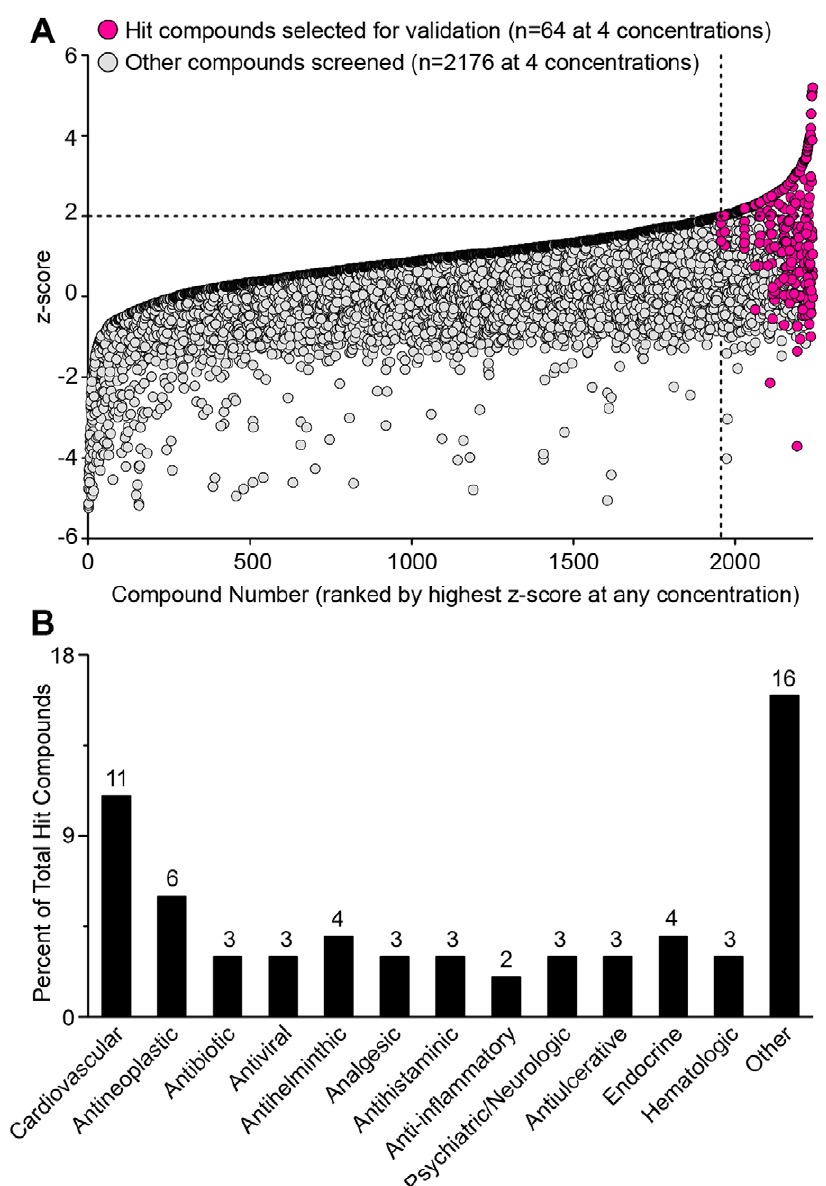
Figure 4. Hit selection and therapeutic class of drugs from primary HTS assay for ISRE activation. (A) Plot of z-scores for each of the 2240 compounds subjected to the primary screen for ISRE activation. Values represent mean of two replicates per compound concentration. Compounds are ranked by highest z-score achieved at any of the four compound concentrations tested. Dashed lines demarcate the compounds with z-scores greater than 2 SD above the mean; and red color denotes the 64 hit compounds selected from this group for validation. (B) The distribution of the 64 hit compounds into various therapeutic classes. Values indicate the number of compounds in each class.